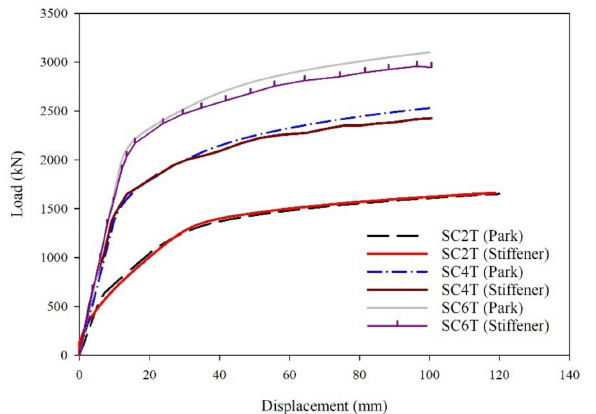
Figure 12. Load–displacement curves of initial models and corrected models equipped with stiff- ener plates.